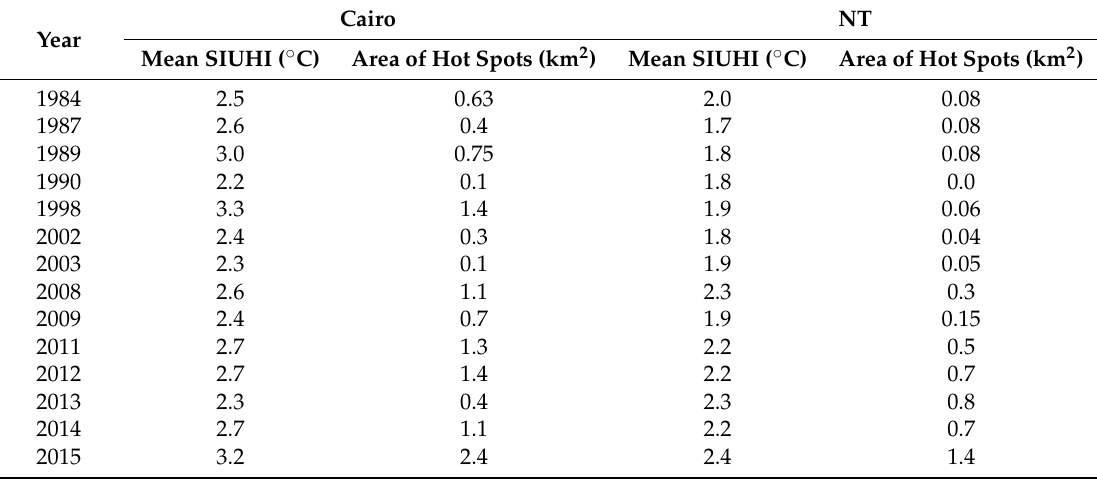
Table 7. The time series of mean SIUHI (Surface Intra-Urban Heat Island) and area of hot spots in Cairo and NT.